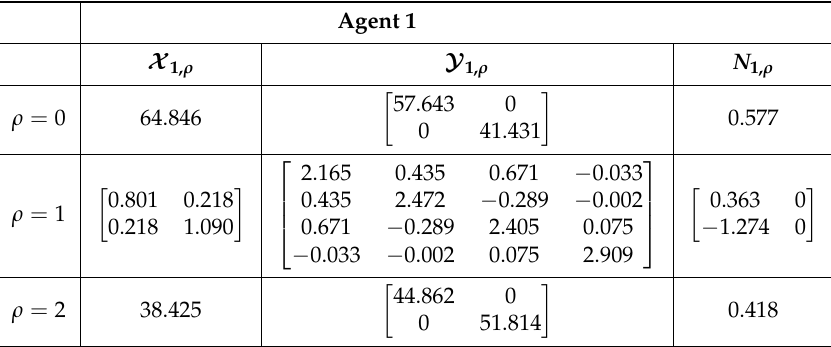
Table 1. Values of X 1, ρ , Y 1, ρ and N 1, ρ obtained in Theorem 3 for agent